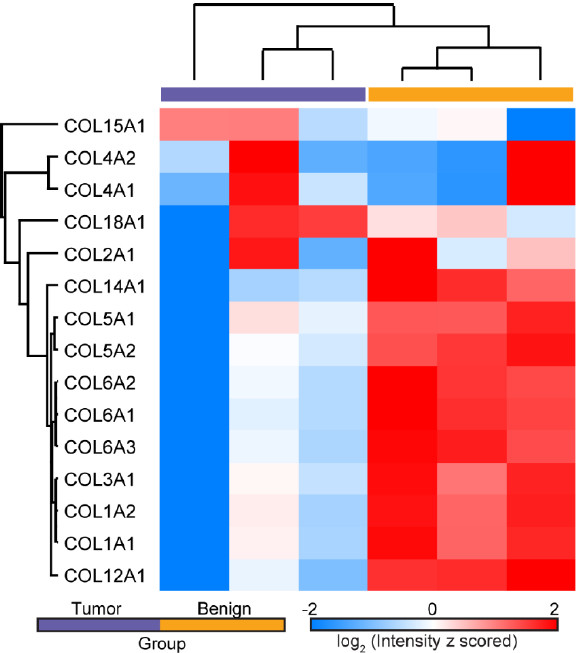
Figure 1. Hierarchical clustering of LFQ ion intensities showing the differential expression of single α -chains from several collagen isoforms in normal ovarian and HGSOC tissues. Several chains were down-regulated in HGSOC.